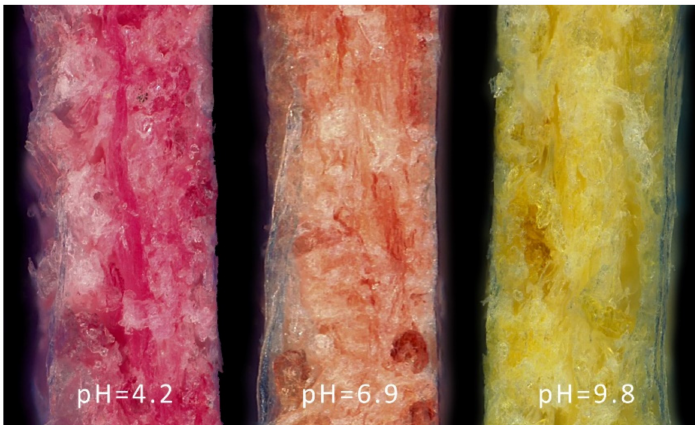
Figure 2. Cross-section of the calibration paper